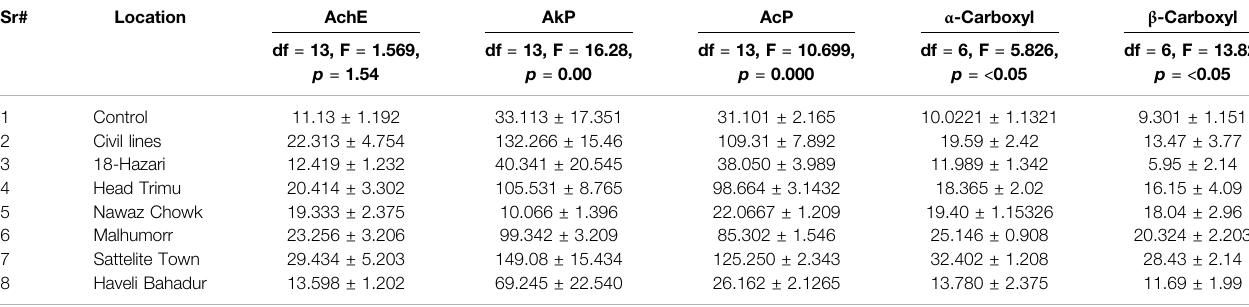
TABLE 3 | Effect of insecticides on the percent enzyme inhibition in Musca domestica L. from District Jhang. Sr# Location AchE AkP AcP α -Carboxyl β -Carboxyl